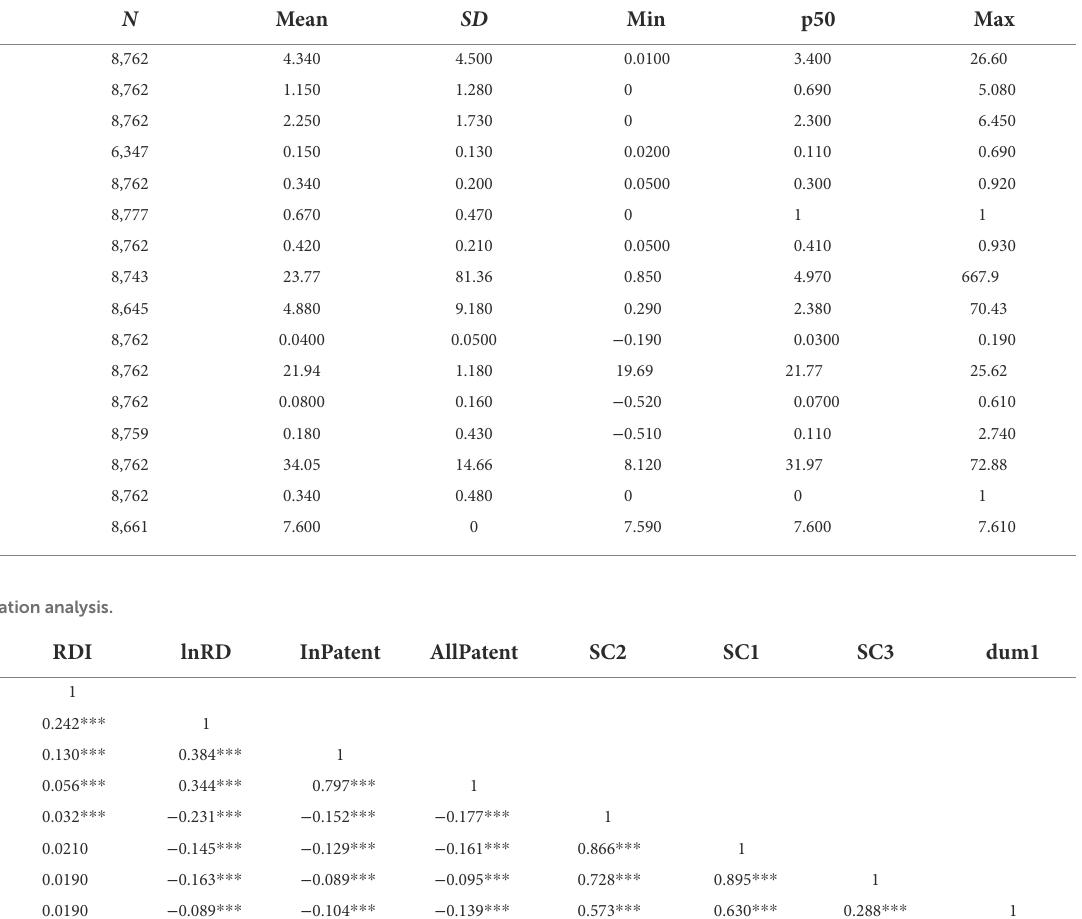
TABLE 2 Summary statistics.